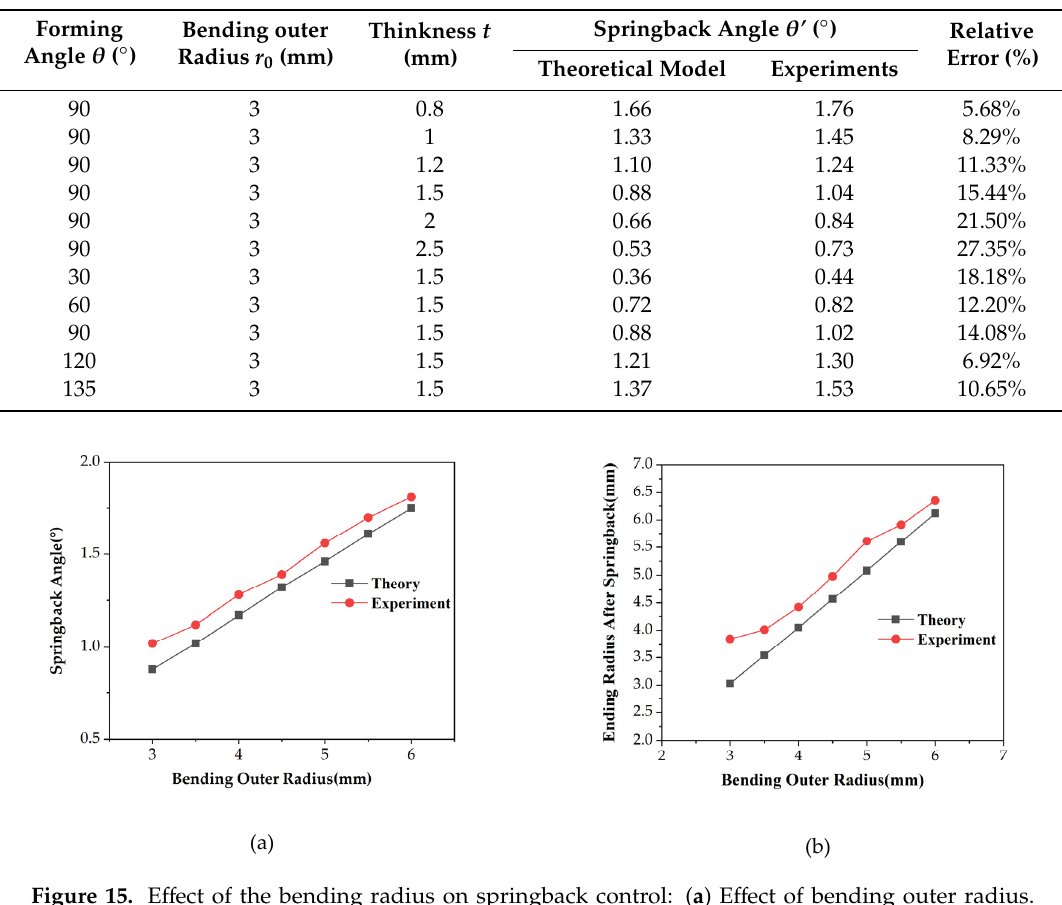
Table 2. Comparison of theoretical and test values under di ff erent forming angles and thicknesses.